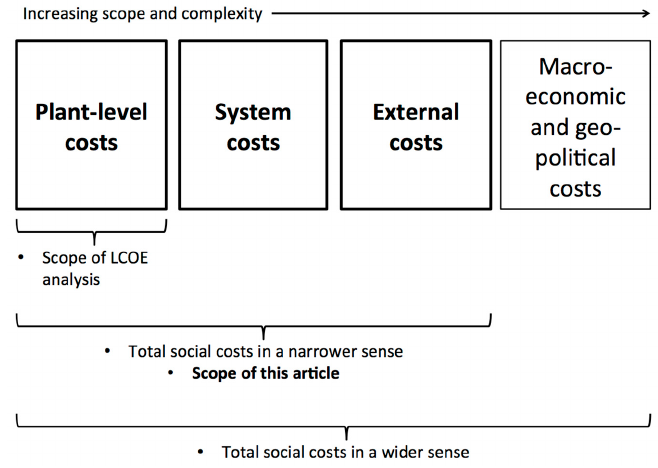
Figure 1. Overview of the main cost categories that can be differentiated when determining the total social costs of electricity generation.